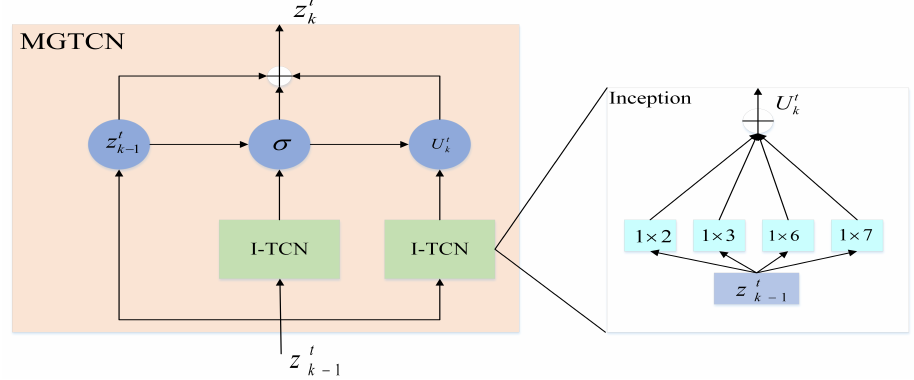
Figure 3. The model structure of